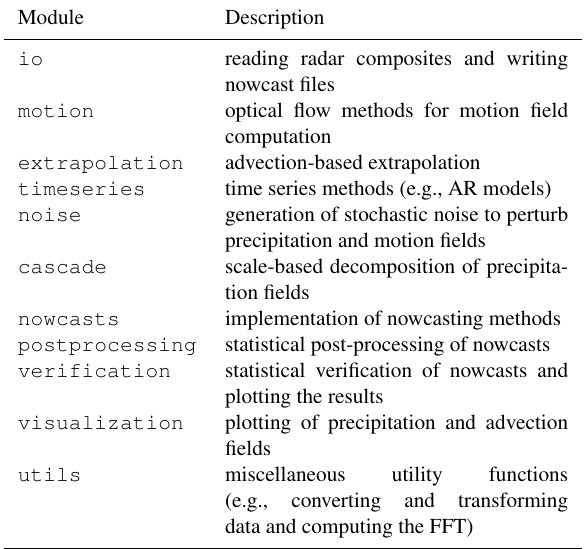
Table 3. Overview of pysteps